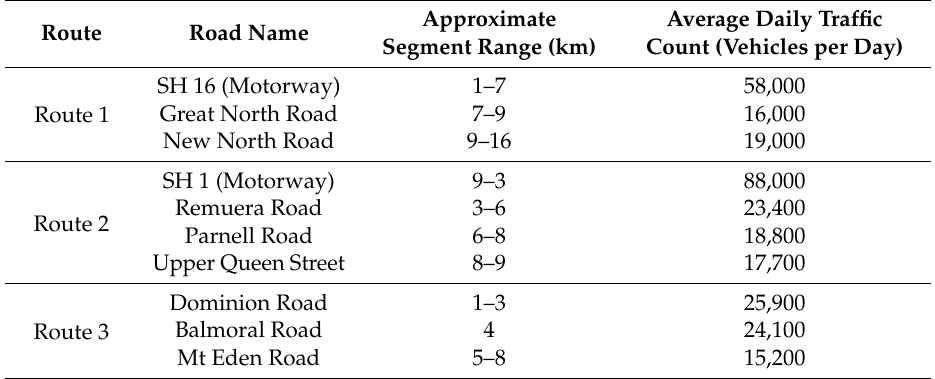
Table 1. Average daily number of vehicles per day and their associated route segments for each of the routes presented in Figure